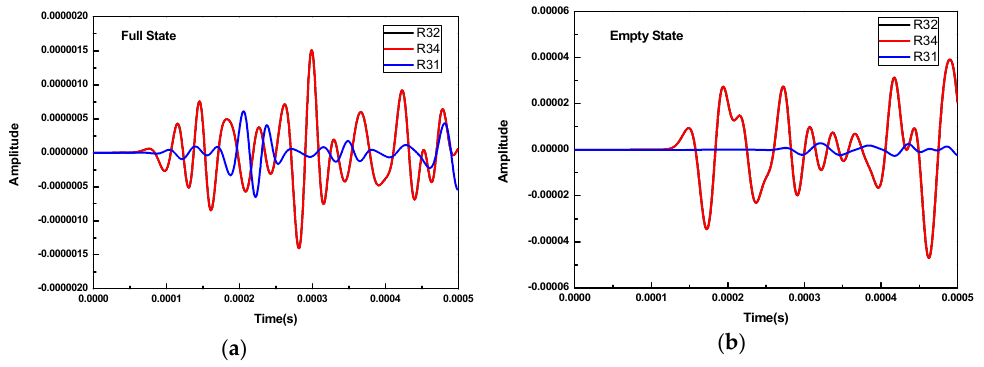
Figure 3. The waveforms received by R1, R2, and R4 when R3 was the transmitter: ( a ) full concrete infill; ( b ) empty concrete infill.